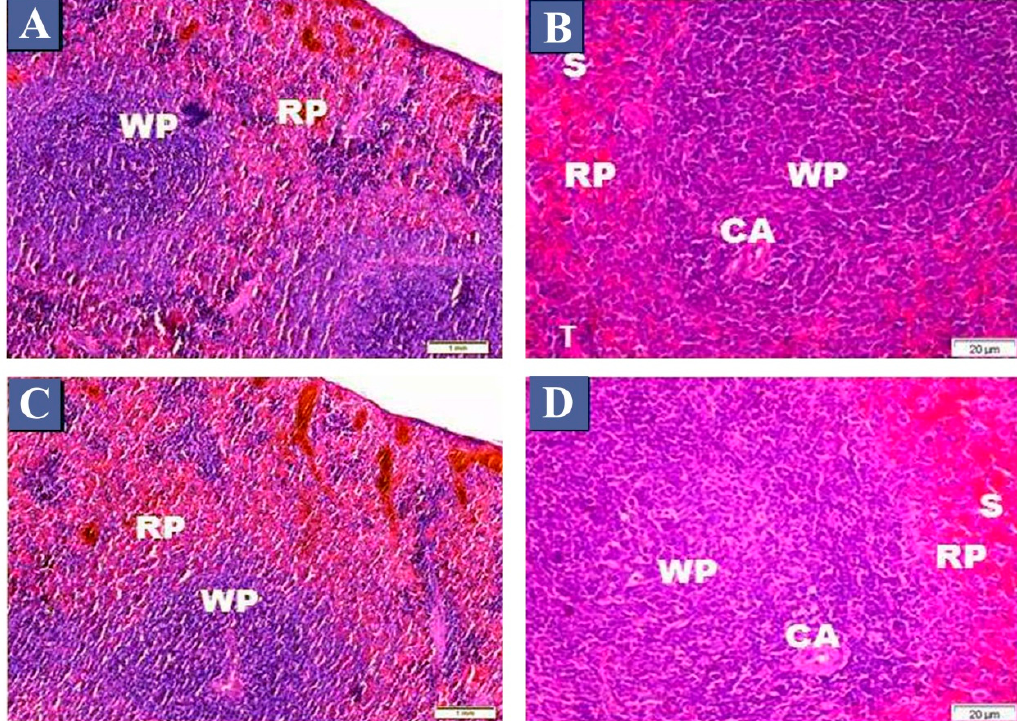
Figure 1. Photomicrographs of haematoxylin and eosin (H&E) stained sections of the spleen from the control group and vitamin C group. ( A , B ) the control group, showing the normal arrangement of white pulp (WP) and red pulp (RP). White pulp (WP) contains the central arteriole (CA), surrounded by numerous lymphocytes. Note the darkly stained nuclei of the lymphocytes. Part of the red pulp (RP) with splenic cords have lymphocytes, blood sinusoids (S) and trabeculae (T). ( C , D ) The vitamin C group, showing the normal architecture of white pulp (WP), central arteriole (CA), red pulp (RP) and blood sinusoids (S). ( A , C ) H&E, ×100, ( B,D ) H&E, ×400.